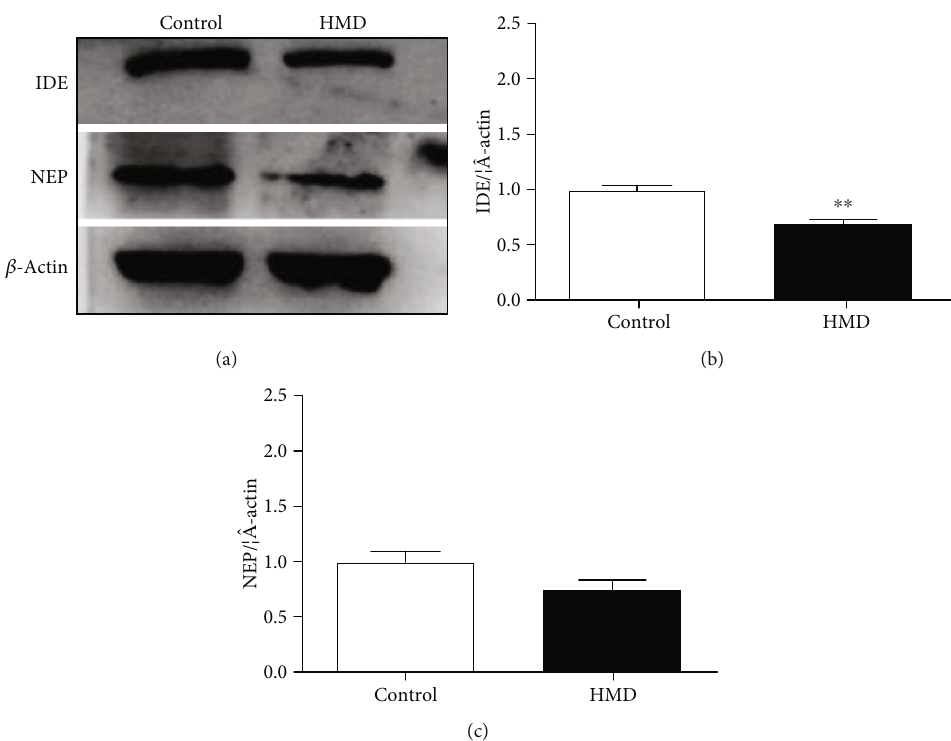
Figure 9: E ff ect of HMD on the expression of A β production-related proteins IDE and NEP in the cortex in mice. (a) Showed representative photomicrographs of IDE and NEP proteins expression of each group in cortex. (b) The protein expression levels of IDE in cortex. (c) The protein expression levels of NEP in cortex. Note: value was expressed as mean ± SEM ( n = 4 ). ∗ p < 0 : 05 vs. control